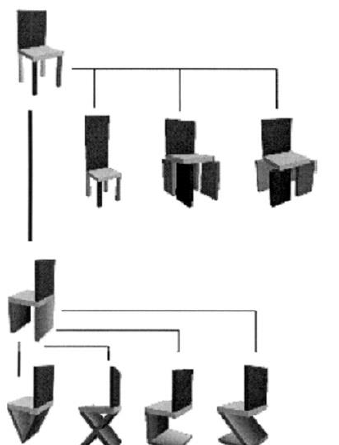
Figure 2. The process of the creative transformation of type through typological emergence. (Oxman, 2001, p.